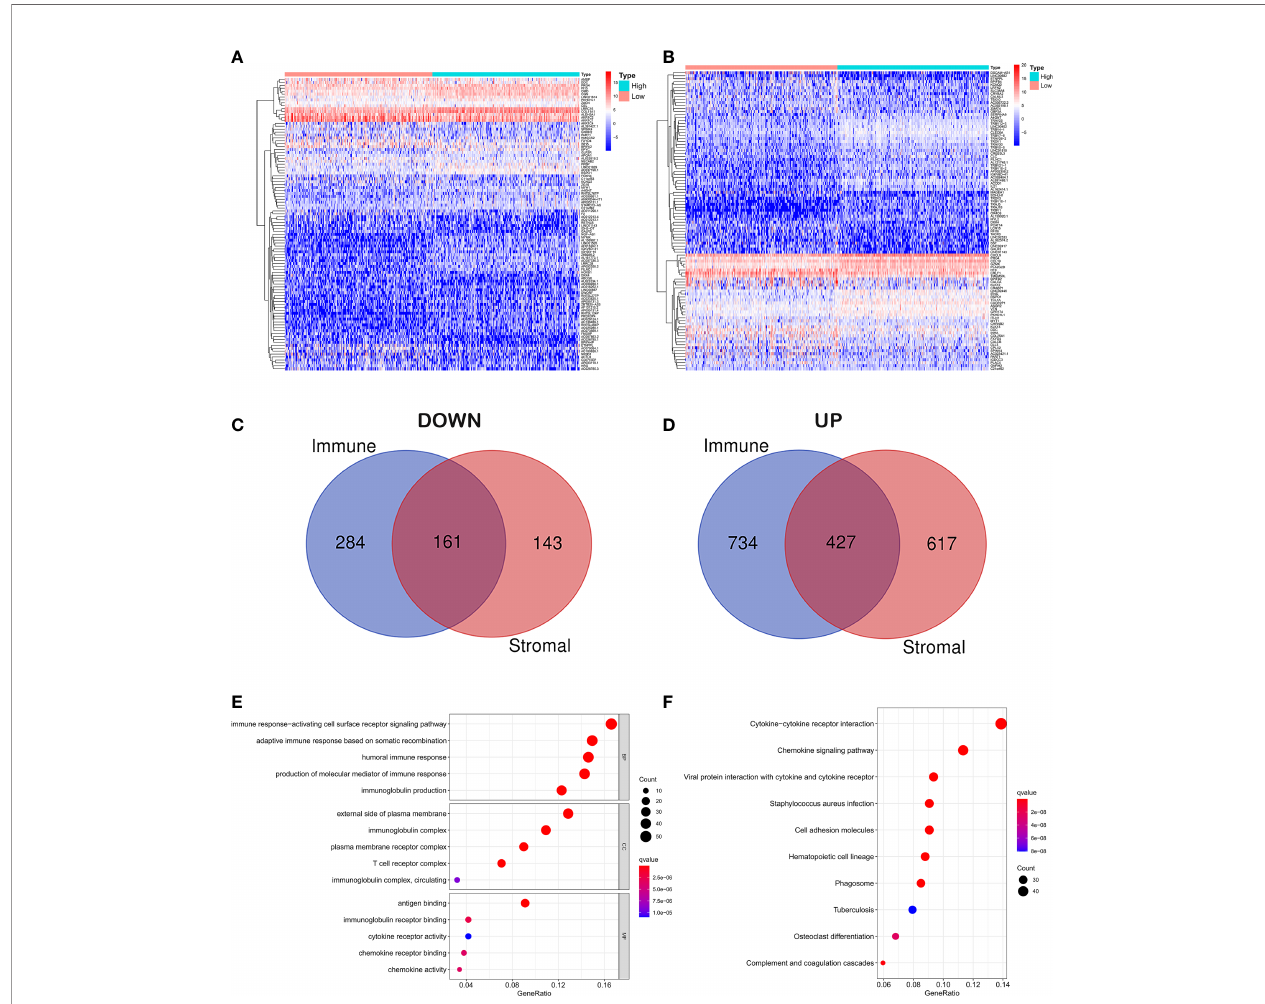
FIGURE 2 | Differential gene expression analysis and enrichment analysis. (A) Differential analysis of stromal cell components. (B) Differential analysis of immune cell components. (C) Overlapping genes that were downregulated in the immune group and the interstitial group. (D) Overlapping genes that were upregulated in the immune group and the interstitial group. (E) GO analysis of DEGs classi fi ed DEGs into three functional groups: CC, BP, and MF group. (F) Signaling pathway analysis of